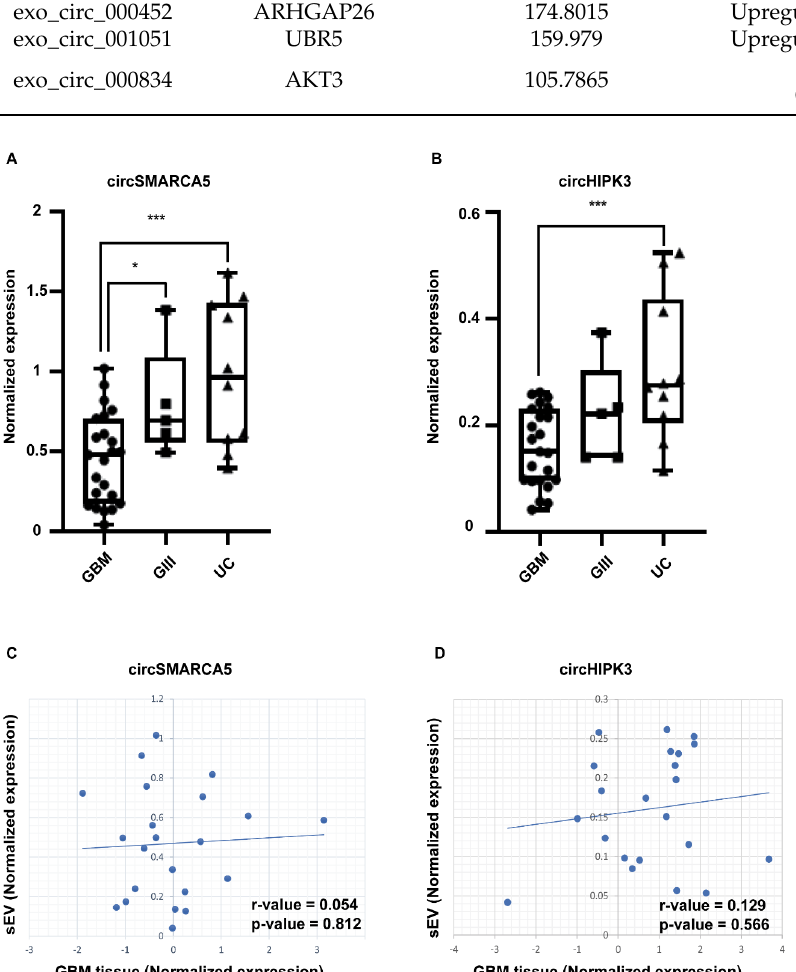
Table 1. Candidate DE circRNAs in gliomas and their expression in sEVs from healthy individuals according to exoRBase (http://www.exorbase.org/exoRBase/toIndex, access on April 2020). Median expression data are reported as reads per million (RPM).